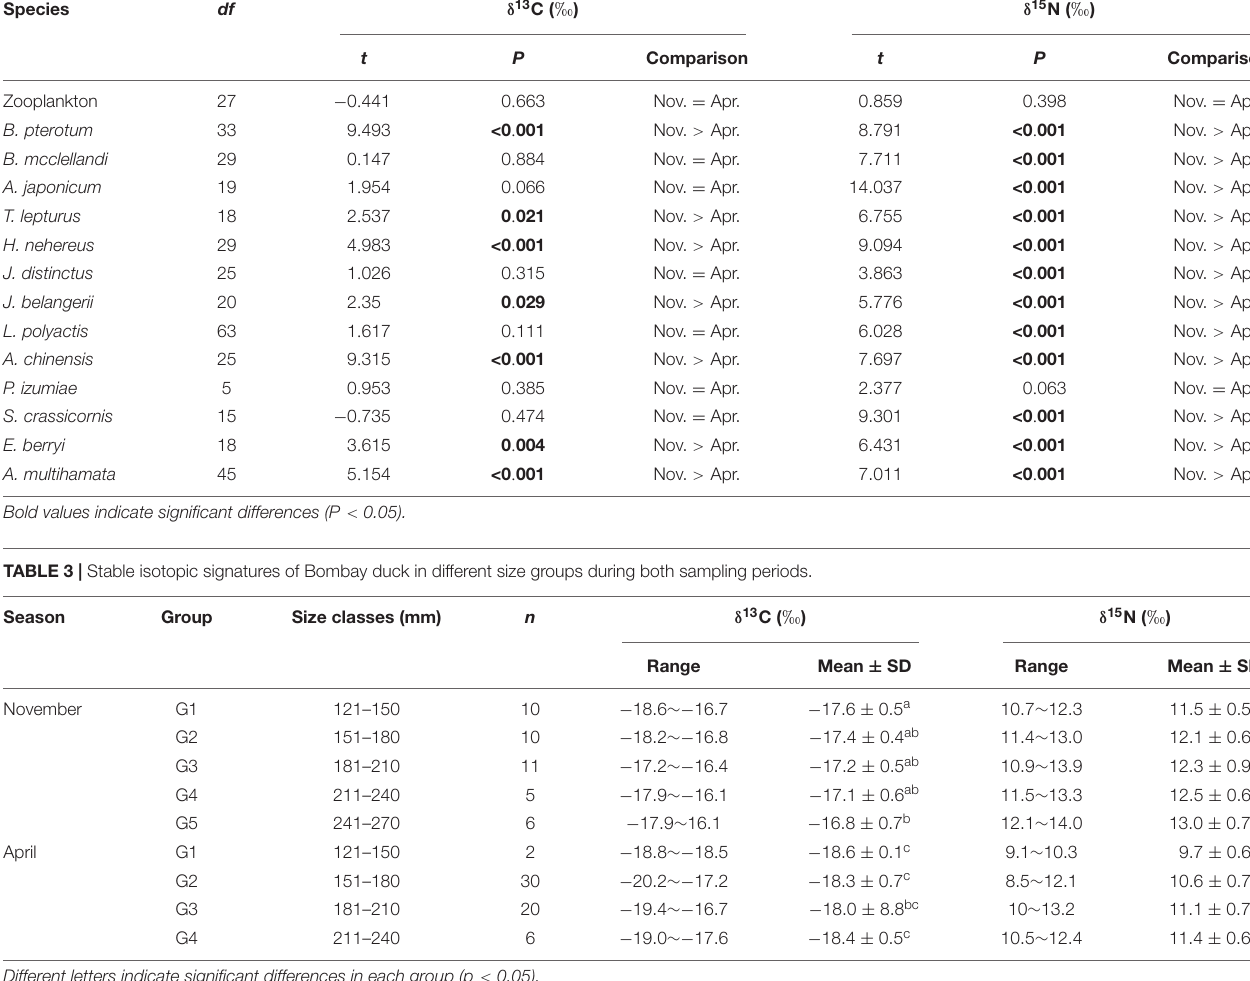
TABLE 2 | Temporal variation in stable isotope signatures ( δ 13 C and δ 15 N) for Bombay duck’s prey in the south central East China Sea. Species df δ 13 C ( ) δ 15 N ( (cid:104) t P Comparison t P Comparison Zooplankton